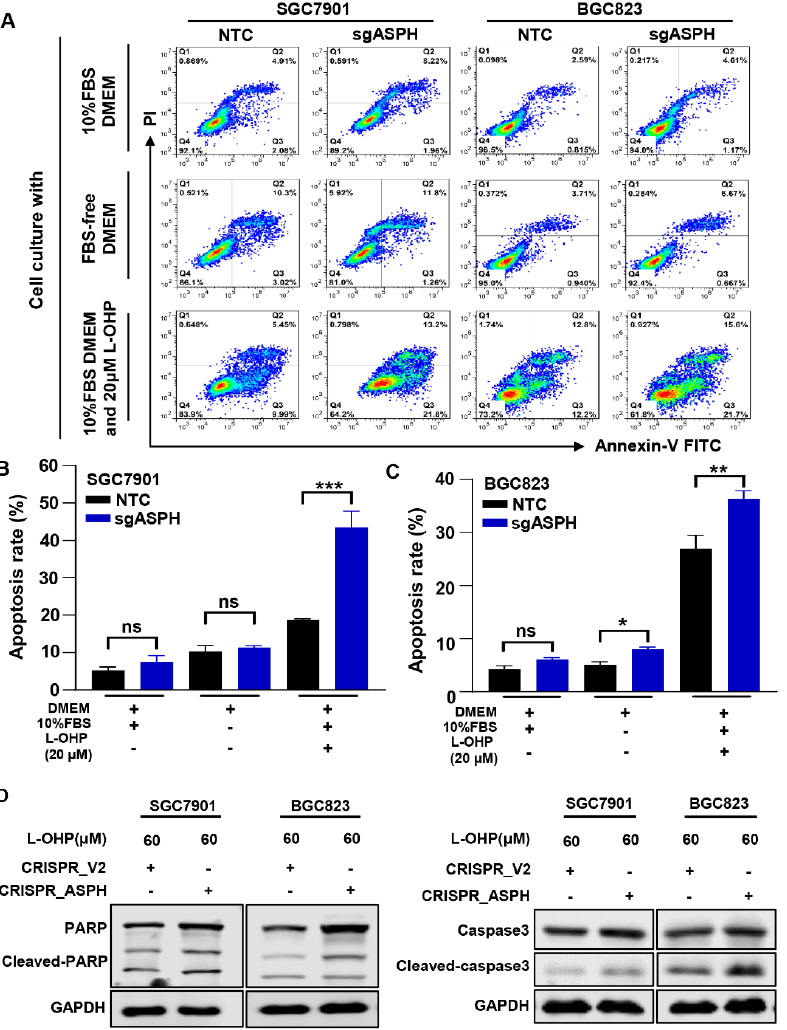
Figure 3. Knockout of ASPH enhances GC cells’ sensitivity to chemotherapeutic agents. ( A ) Apoptotic rate of BGC823 and SGC7901 cells after ASPH knockout was detected by flow cytometry. Cells cultured with normal 10% FBS DMEM, FBS-free DMEM or 10% FBS DMEM with L-OHP (60 µ M) for 24 h. ( B , C ) The ratio of apoptosis cells was assessed by flow cytometry assay (n = 3, two independent experiments). ( D ) SGC7901 and BGC823 cells with or without ASPH knockout were treated with 60 µ M L-OHP for 24 h. Western blot was used to detect the protein levels of PARP, cleaved PARP, caspase-3, cleaved-caspase3, and GAPDH as an internal reference protein. ns p > 0.05, * p < 0.05, ** p < 0.01, *** p <